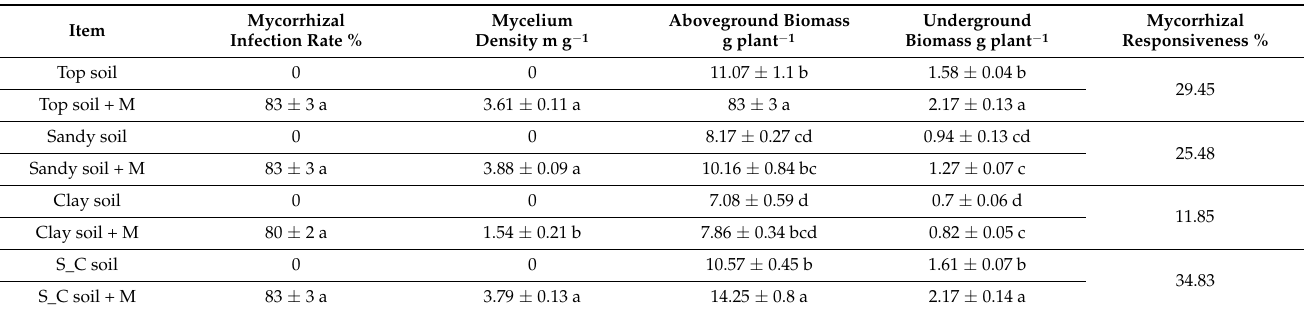
Table 2. Effect of inoculation with AM fungi on plant biomass [91]. Notes: the lowercase letters (a, b, c, d) indicate significant differences ( p <